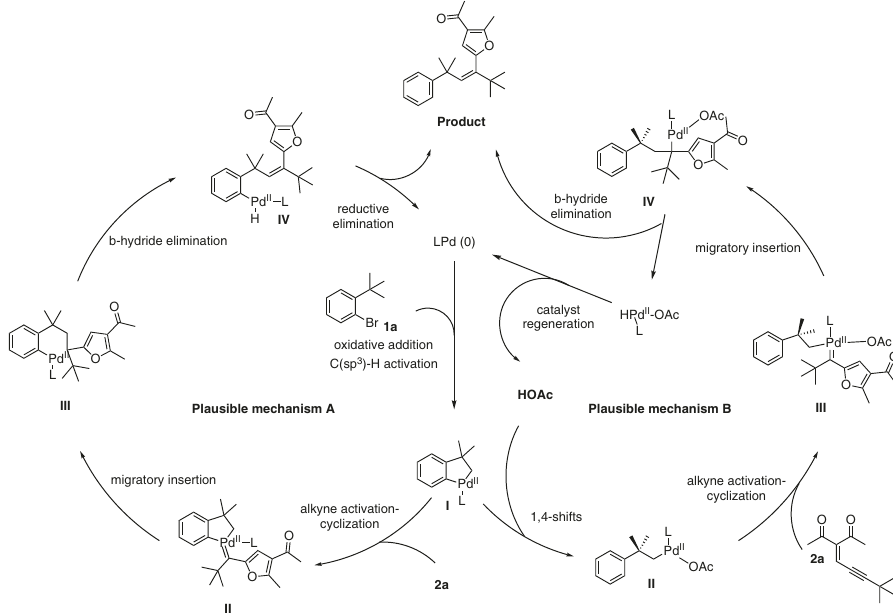
Fig. 7 Two possible catalytic cycles for the reaction. This proposed mechanism contains two possible paths, and path B is more favorable according to DFT calculation